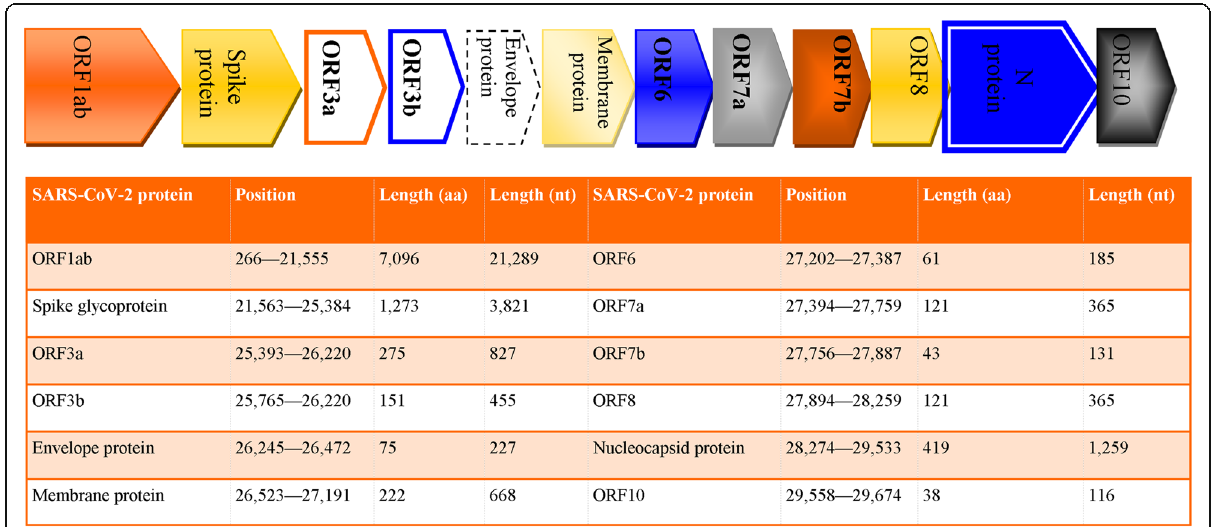
Fig. 1 Schematic representation of SARS-CoV-2 genome with corresponding encoded proteins, their position, and